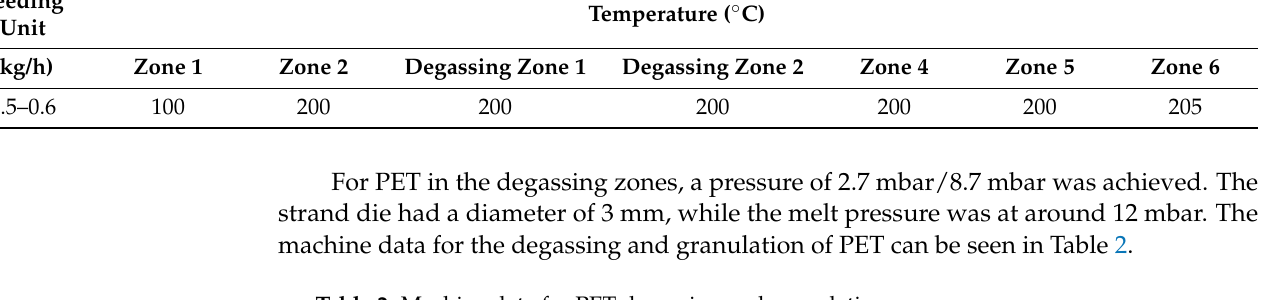
Table 1. Machine data for LDPE degassing and granulation.